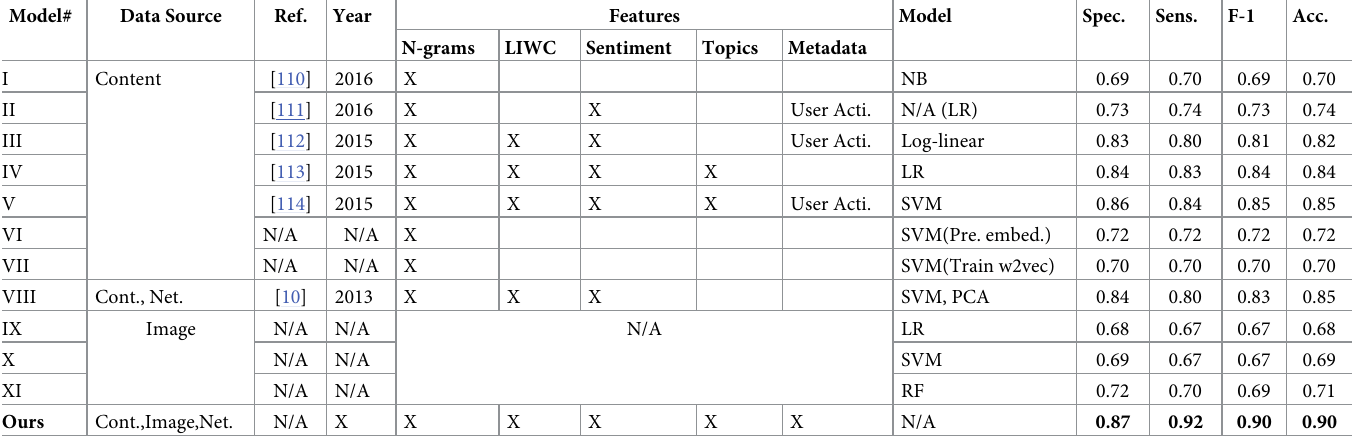
Table 9. Model’s performance for depressed user identification in Twitter using different data modalities. Model# Data